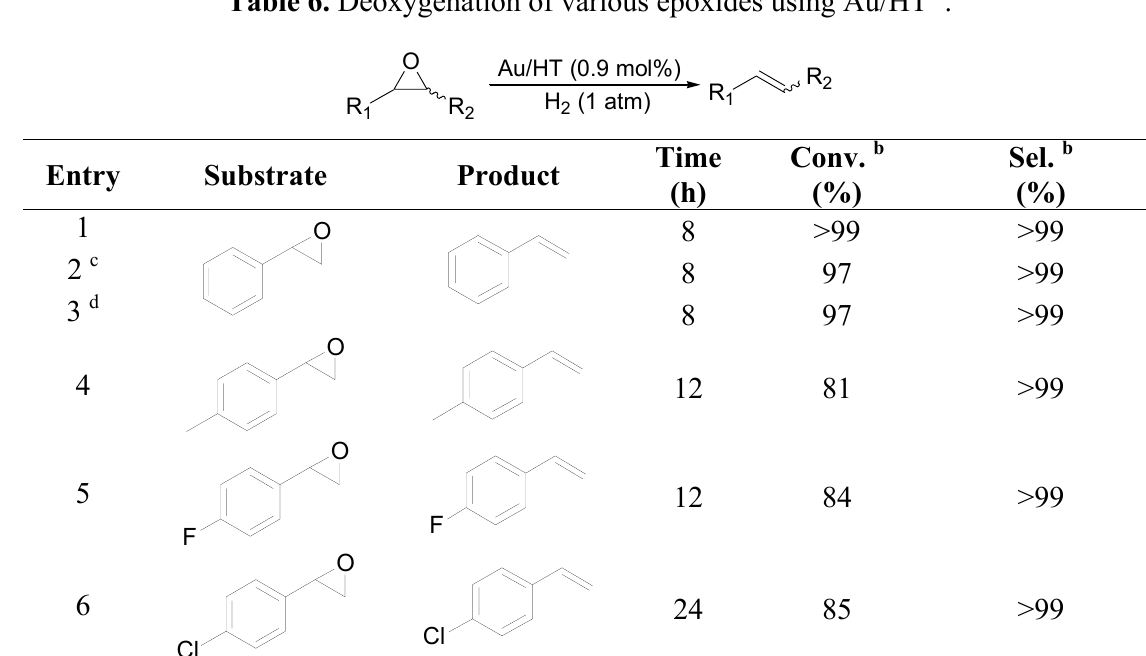
Table 6. Deoxygenation of various epoxides using Au/HT a